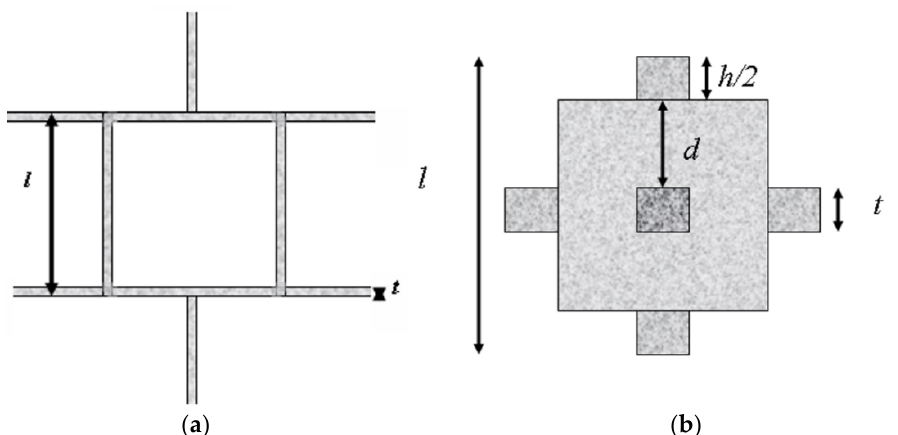
Figure 7. Interconnected thin beams form the cubic structure underlying the GA ( a ) and PD ( b ) models.